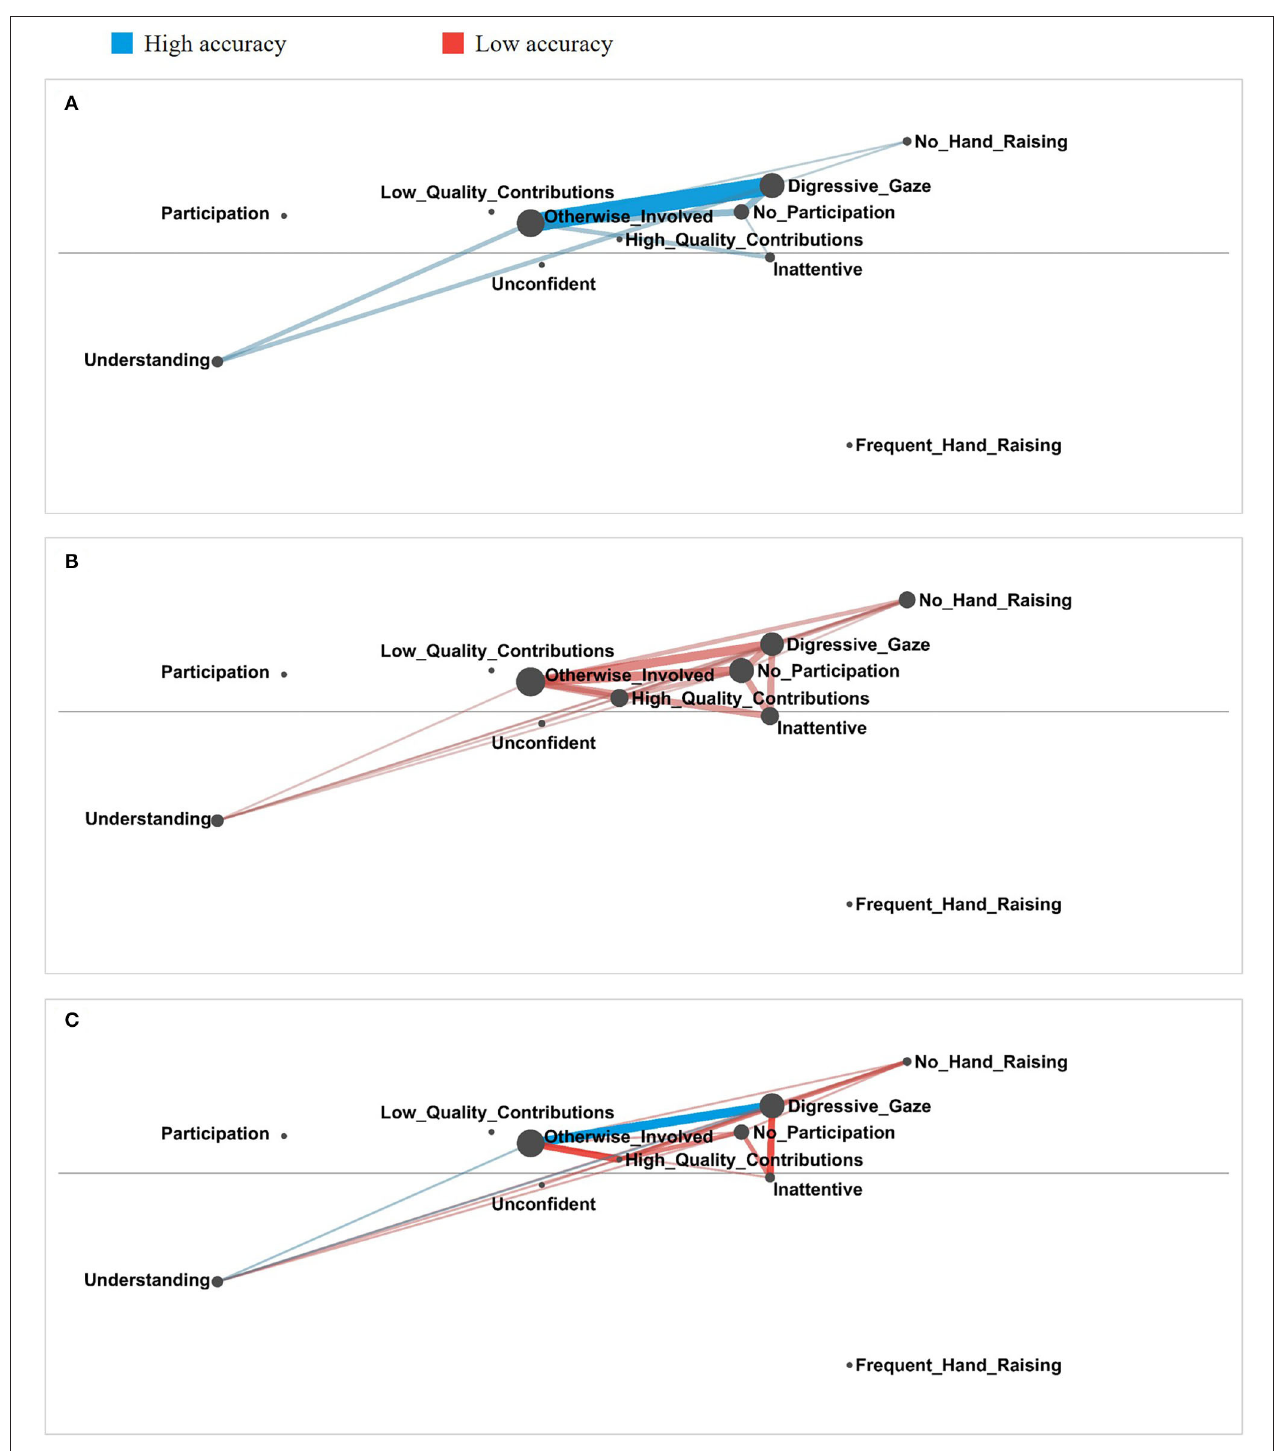
FIGURE 11 | Comparison of networks for uninterested student profile between student teachers with high and low judgment accuracy. (A) Depicts the network of the uninterested student profile for student teachers with high accuracy. (B) Depicts the network of the uninterested student profile for student teachers with low accuracy. (C) Shows the comparison of both networks. Here, the color of connections indicates which group utilized the respective code combination more frequently. In order to make the characteristics of the individual networks clearly visible and to make the differences visually easier to recognize, minimum edge weight and scale for edge weight were set to 0.1 and 1.3,